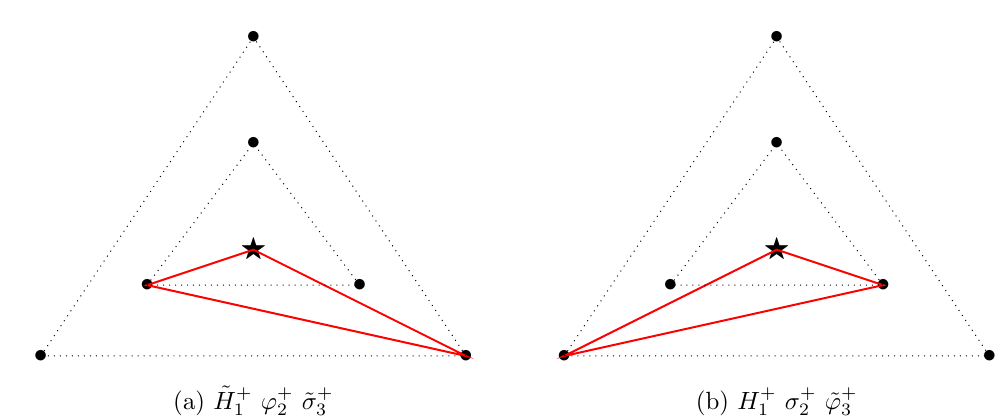
Figure 9. Higgs con(cid:12)guration with non-vanishing cubic potential.